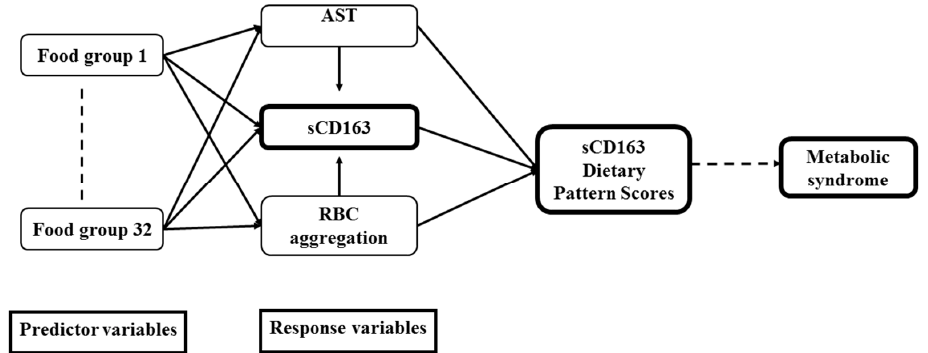
Figure 1. Directed acyclic graph of the reduced rank regression (RRR) conceptual framework. sCD163, soluble cluster of differentiation 163; AST, aspartate transaminase; RBCs, red blood cells.